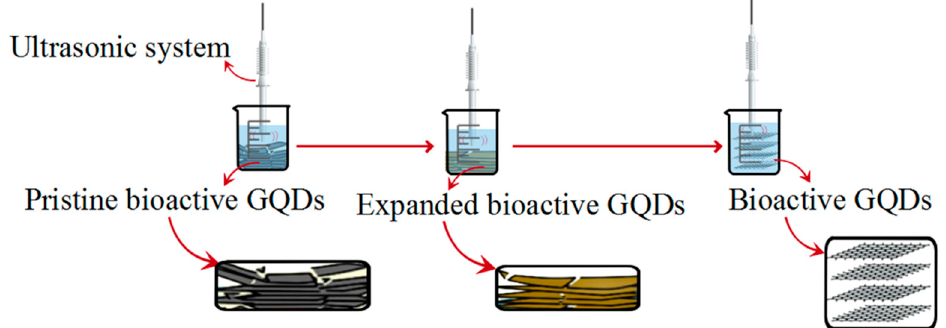
Figure 6. The ultrasonic synthesis